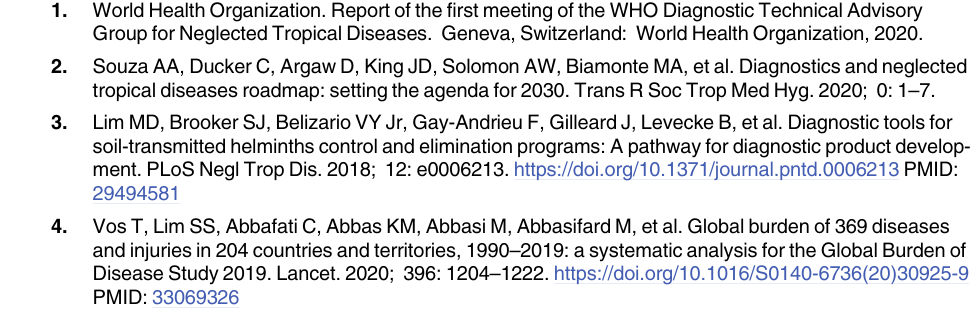
S2 Table. The minimum and ideal sensitivity and specificity recommended by the STH subgroup. S1 Fig. The width of grey zones around 6 program decision thresholds for 1,168 theoretic diagnostic tests. These contour plots illustrate the width of the grey zone for each of the 1,168 unique combinations of sensitivity and specificity when decision making ideal ( ε and ε � 5%)each line represents the same width of grey zone. The number of the beside undertreat the line represents the floor value of the width of the grey zone in % (e.g., any value � 10% and < 11% is set at 10%). S1 Data. The data used to determine the required diagnostic performance, the sample size and the corresponding decision